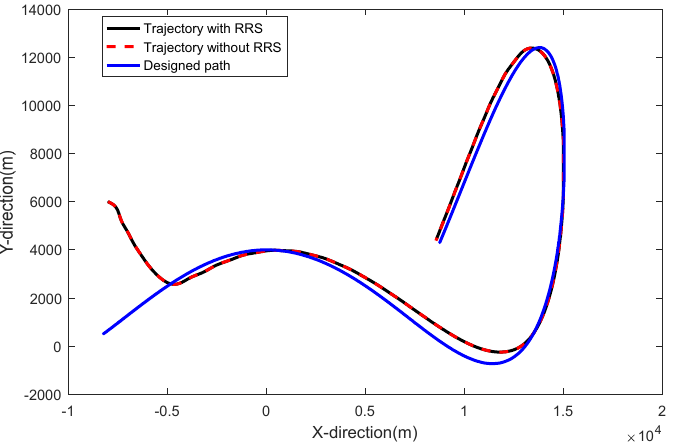
Figure 13. Path-following performances with and without RRS control.